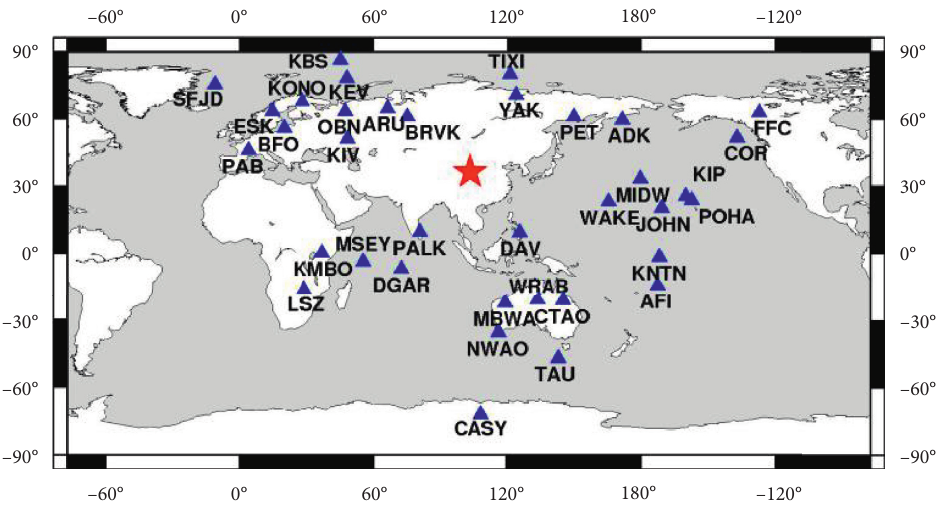
Figure 2: The locations of the Wenchuan earthquake and teleseismic